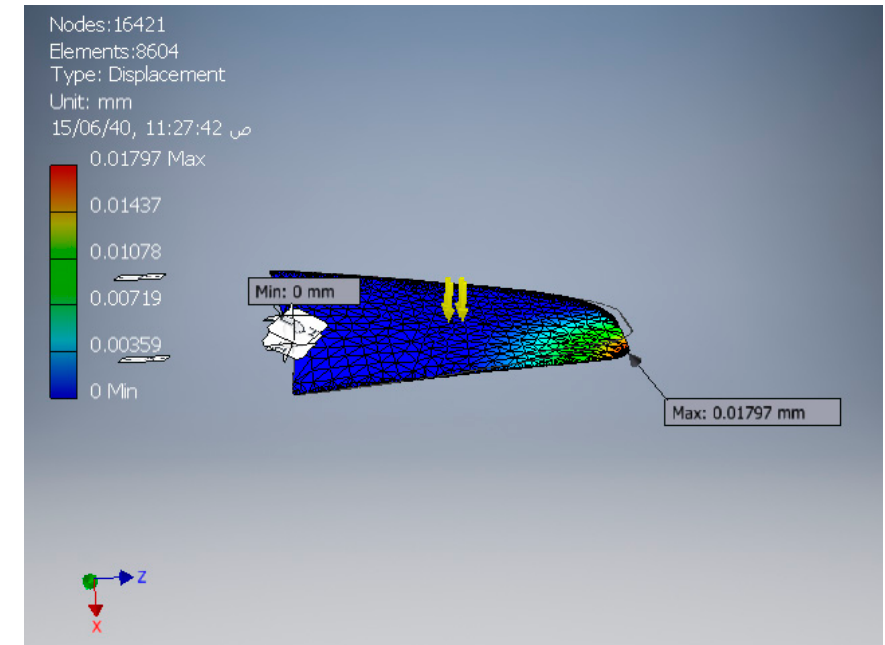
Figure 4. Blade deflection for the applied loading conditions.